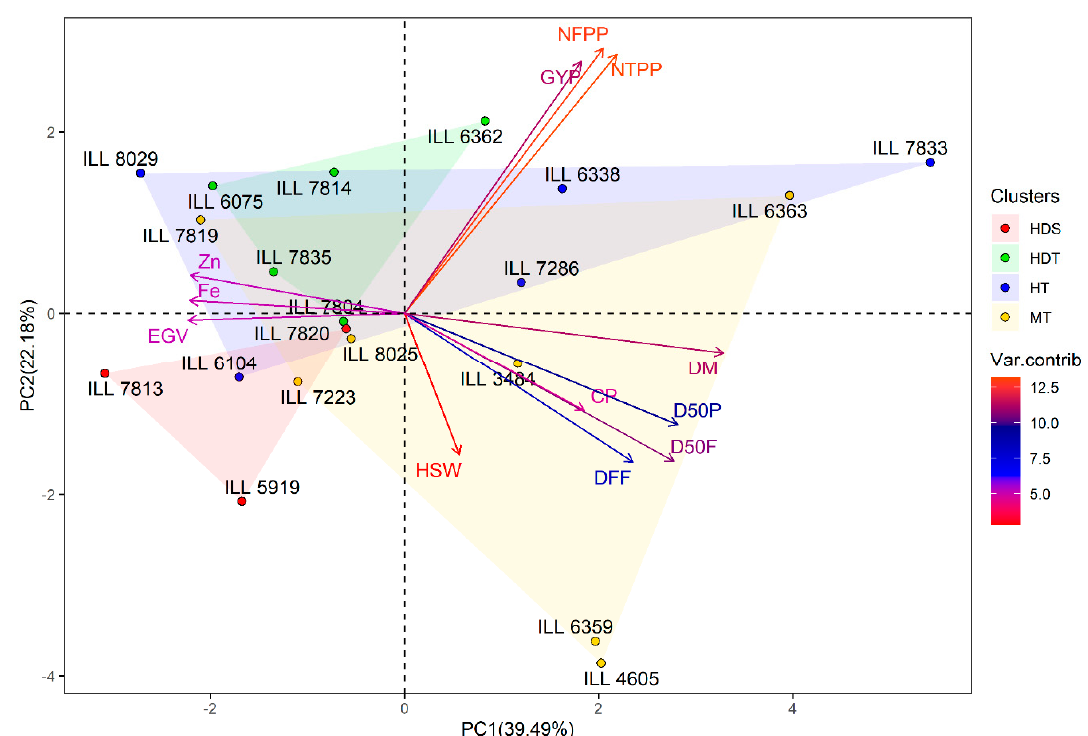
Figure 4. Biplot of the first two axes of the PCA analysis summarizing the relationship between the measured variables and the classification of lentil genotypes under the combined temperature -drought stress conditions. HDS, heat-drought susceptible; HDT, heat-drought tolerant; HT; heat tolerant and MT, moderately tolerant to heat-drought